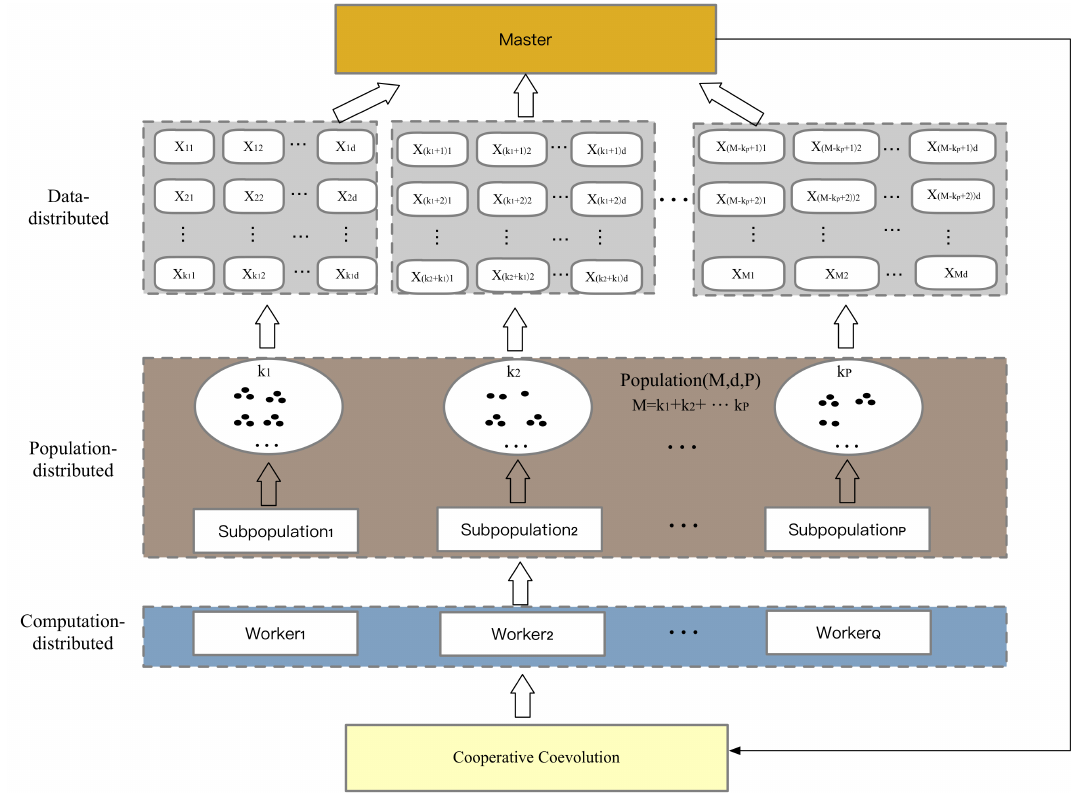
Figure 1. The distributed cooperative evolutionary algorithm framework using Spark (SDCEA)